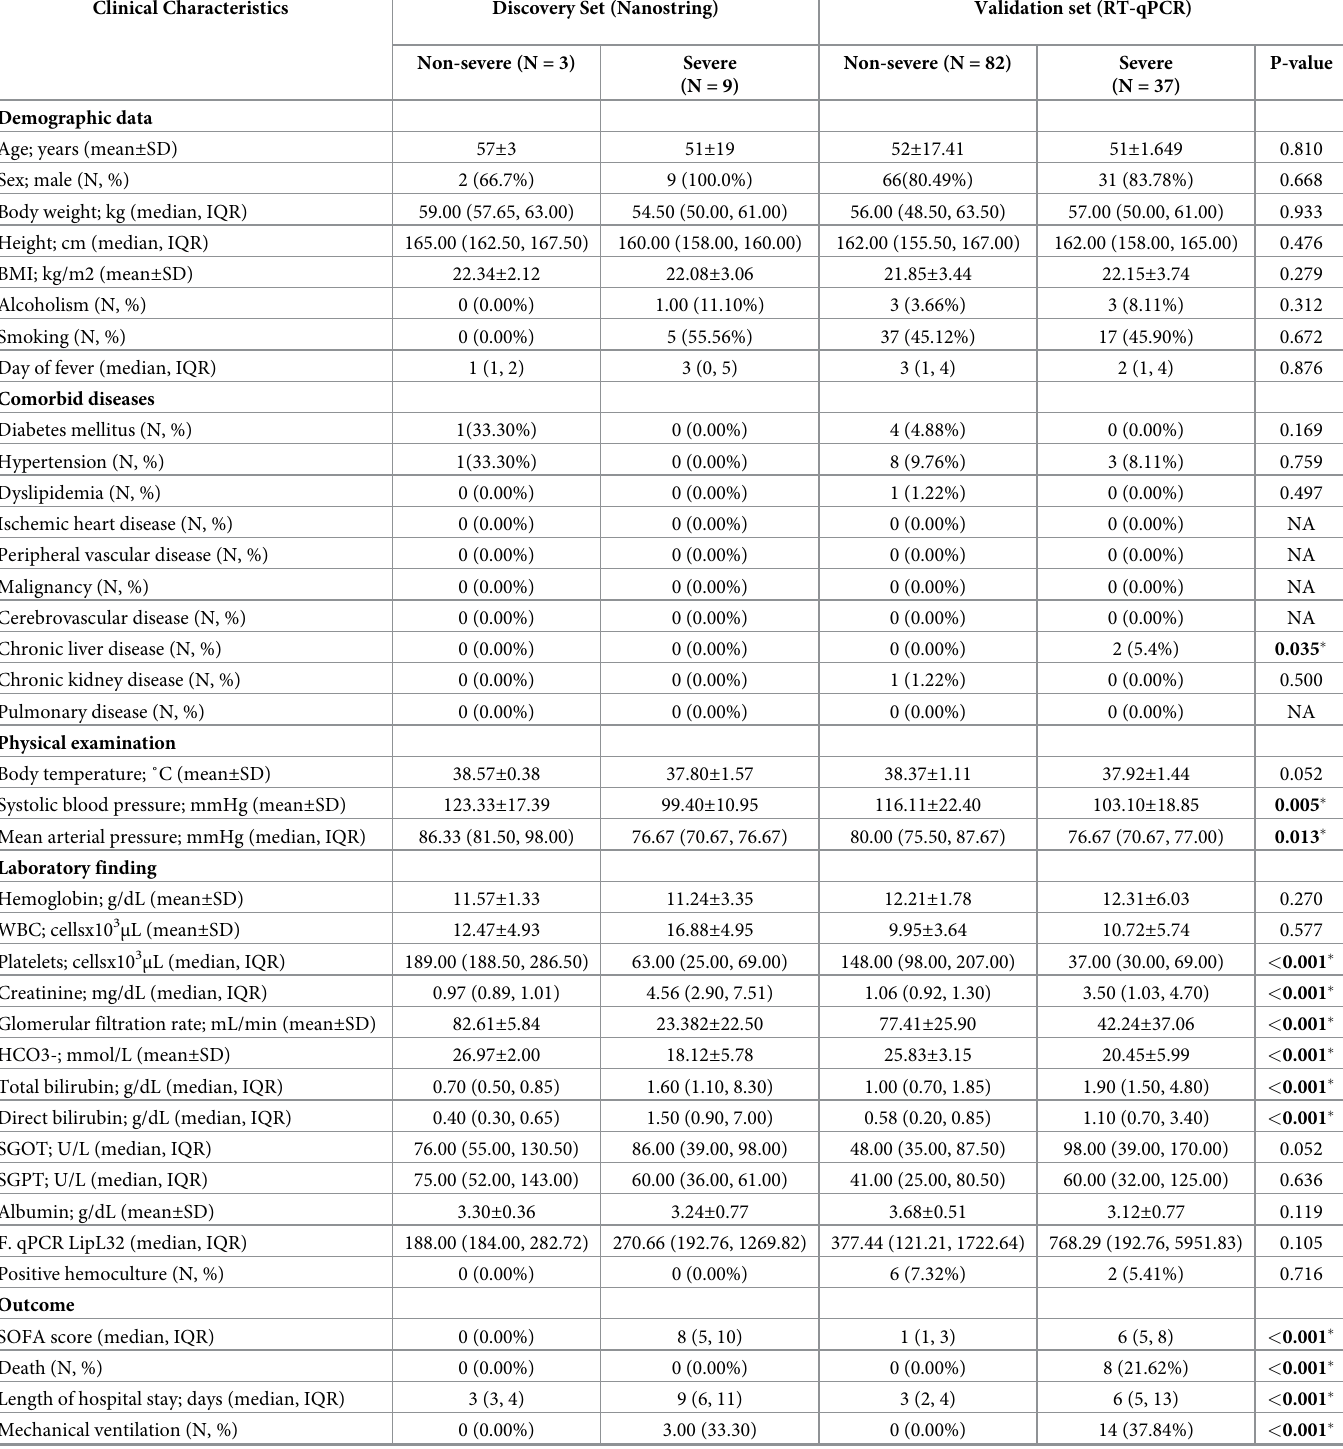
Table 1. Baseline demographic